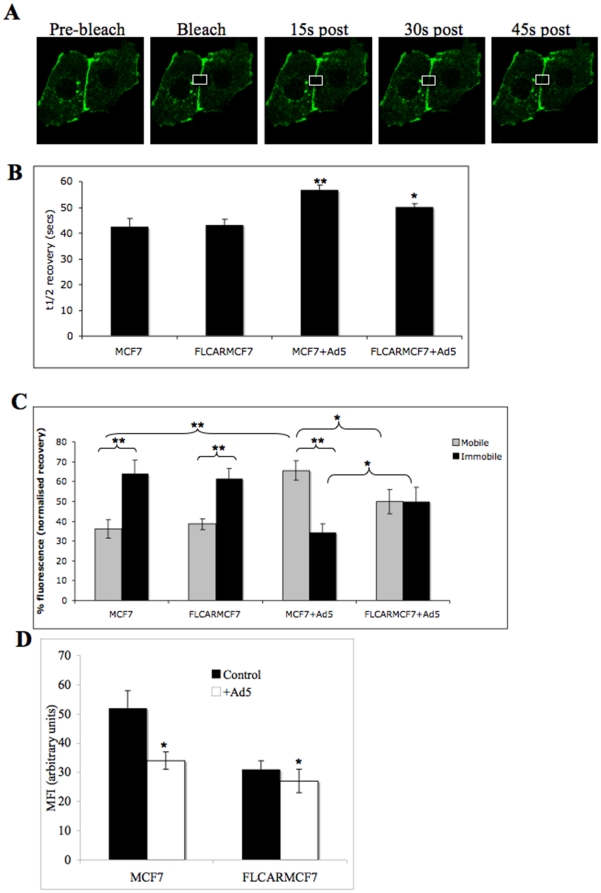
E-cadherin is more dynamic within junctions in the presence of Ad5eGFP.(A) Example images from a FRAP experiment on MCF7 cells expressing E-cadherin-GFP. MCF7 were transiently transfected with E-cadherin-GFP for 24 hours before being plated on glass bottomed imaging chambers. Images were captured, analysed and exported using NIS Elements AR software. An image was taken immediately after the bleach and one 5 seconds after that, and then images were taken every 15 seconds for 5 minutes. Images shown for pre-bleach, bleach (bleached region shown in white box) and the recovery of E-cadherin-GFP monitored at 15 s, 30 s and 45 s post-bleach. (B) The half-life (τ1/2) of E-cadherin recovery after photobleaching MCF7 and FLCARMCF7 cells in the absence or presence of Ad5eGFP (MCF7+Ad5 and FLCARMCF7+Ad5 respectively). E-cadherin recovery was defined from corrected intensity data fitted to a single exponential equation and calculated using the equation t
1/2 = ln 0.5/−τ. Data was pooled from >12 cells per condition over 4 independent experiments +/− SEM. Significance was determined by two-way anova. ** = p<0.001 compared to MCF7 cells no Ad5eGFP; * = p<0.05 compared to FLCARMCF7 no Ad5eGFP; * = p<0.05 compared to FLCARMCF7 with Ad5eGFP. (C) Mobile and immobile E-cadherin fractions in MCF7 and FLCARMCF7 cells in the absence or presence of Ad5eGFP (MCF7+Ad5 and FLCARMACF7+Ad5 respectively). Mobile and immobile fractions were defined as the percentage recovery at plateau (mobile) and remaining non-recovered fraction at this time (immobile fraction). Significance was determined by two-way anova. * * = P<0.001 * = P<0.05. (D) FACS analysis of cell surface E-cadherin levels on MCF7 and FLCARMCF7 cells without (black bars) or with Ad5eGFP (9000 VP/cell; white bars). MFI is shown pooled from 3 independent experiments +−/SEM. Significance was determined by a two-way anova. * = p<0.05 compared to MCF7 no Ad5eGFP levels.